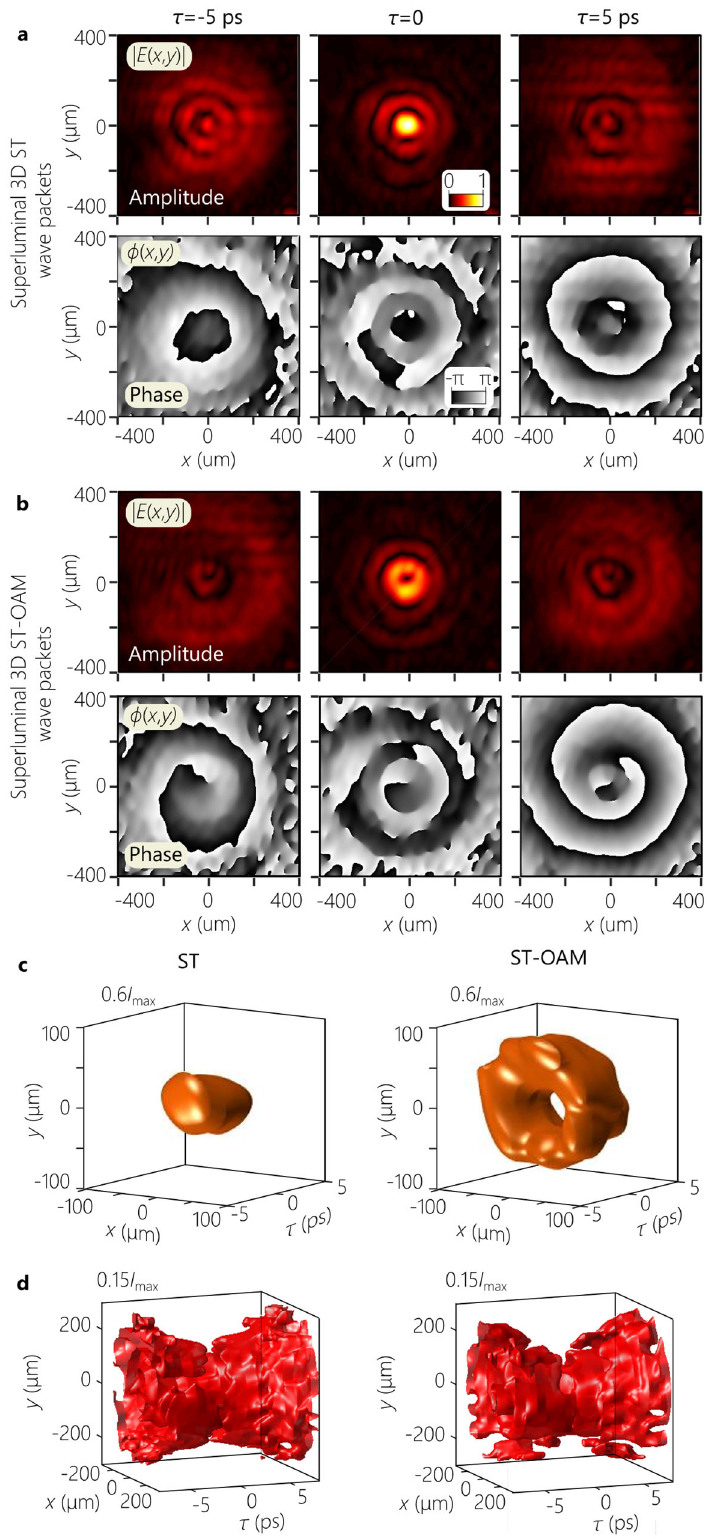
Fig. 7 | Measured complex- fi eld amplitude and phase pro fi les for 3D ST wave packets with and without OAM. a Measured amplitude ∣ ψ ( x , y ) ∣ ( fi rst row) and phase ϕ ( x , y ) (second row) at a fi xed axial plane z =30 mm (see Figs. 5 and 6) at delays τ = − 5 ps, τ =0 corresponding to the wave-packet center, and τ =5 ps for a